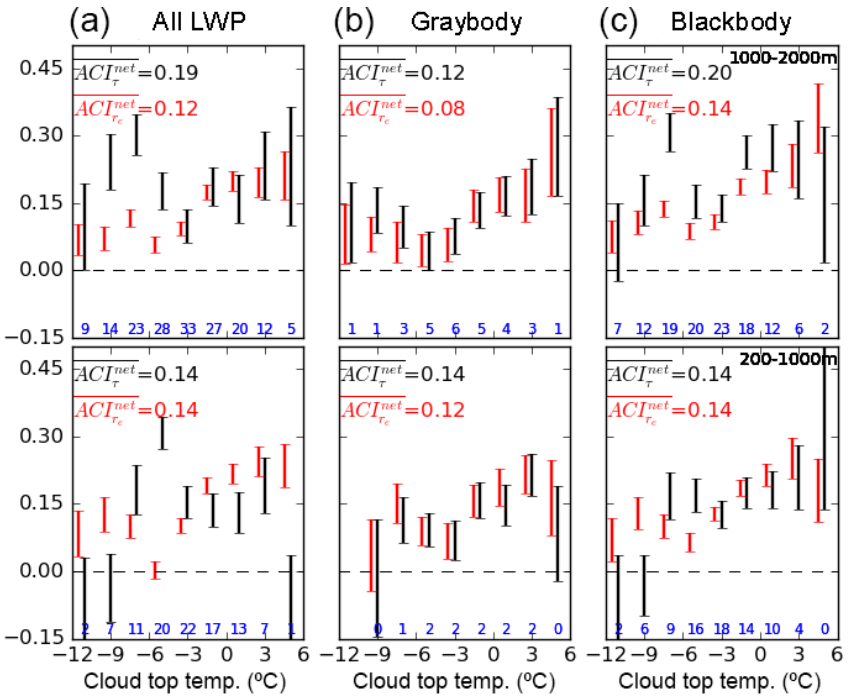
Figure 5. ACI net parameter of the effective radius ( r e ) (red) and optical depth ( τ ) (black), as a function of temperature calculated for liquid clouds between 200–1000m (lower row) and 1000–2000m (upper row). The bars indicate the 95% confidence limit in the calculation of the mean ACI net value. Each column corresponds to different thresholds for LWP (blackbody: LWP > 40gm − 2 , graybody: LWP < 40gm − 2 ). Blue numbers indicate the number of grid cells, in hundreds, that are used to calculate each ACI net value. In each figure the ACI net value averaged over the temperature and weighted according to the inverse of the uncertainty is